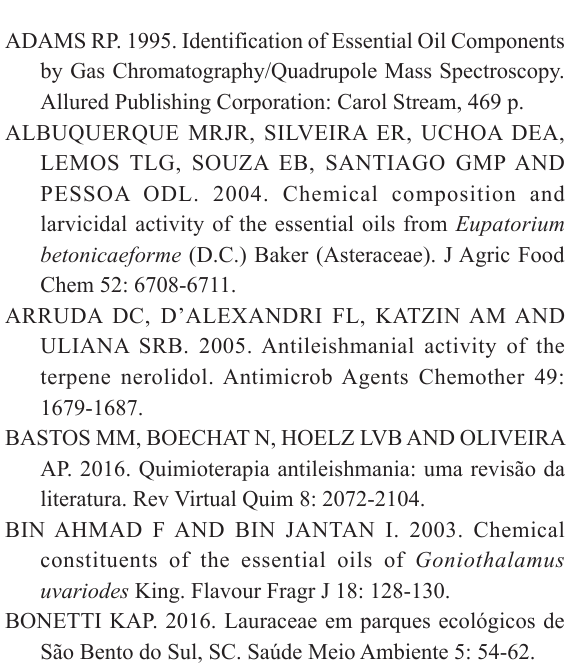
EOCA : Leaf essential oil of Cryptocarya aschersoniana . Amph. B: Amphotericin B. Positive control: 25.0% DMSO; Negative control: 0.1%